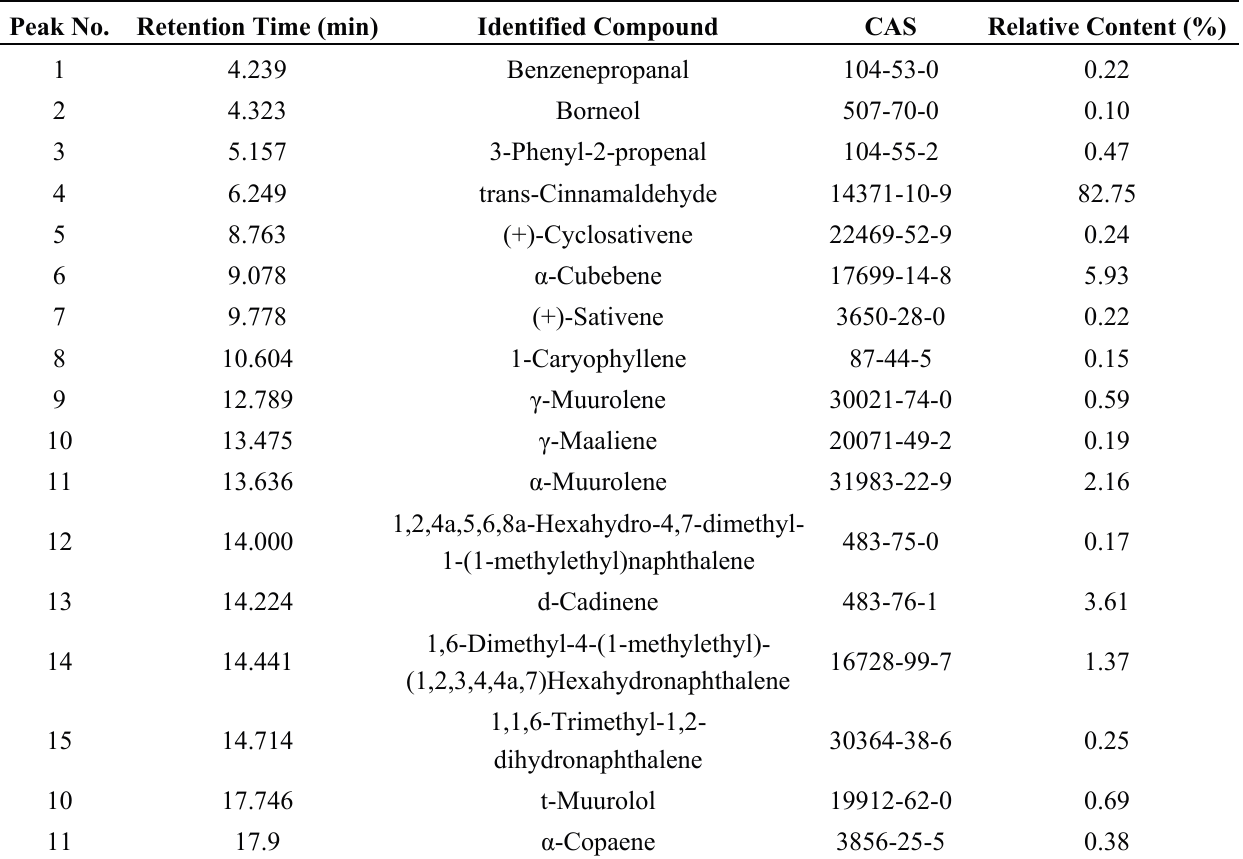
Table 4. Chemical composition of Cinnamon oil.